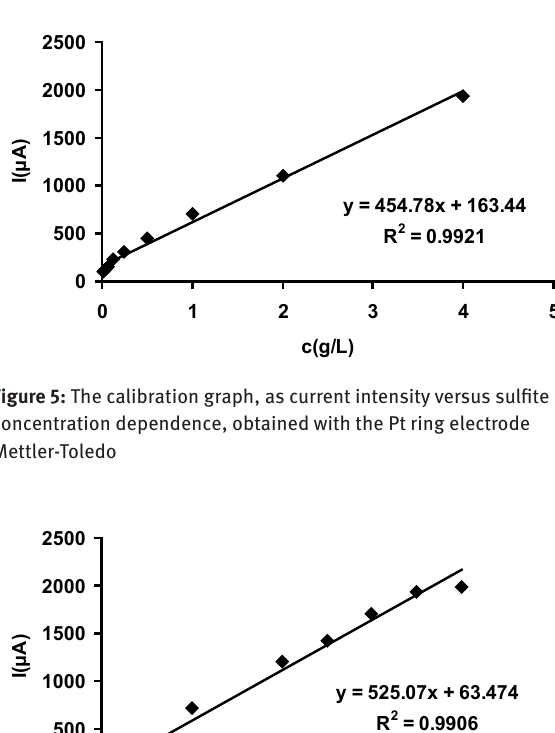
y = 599.79x + 124.55